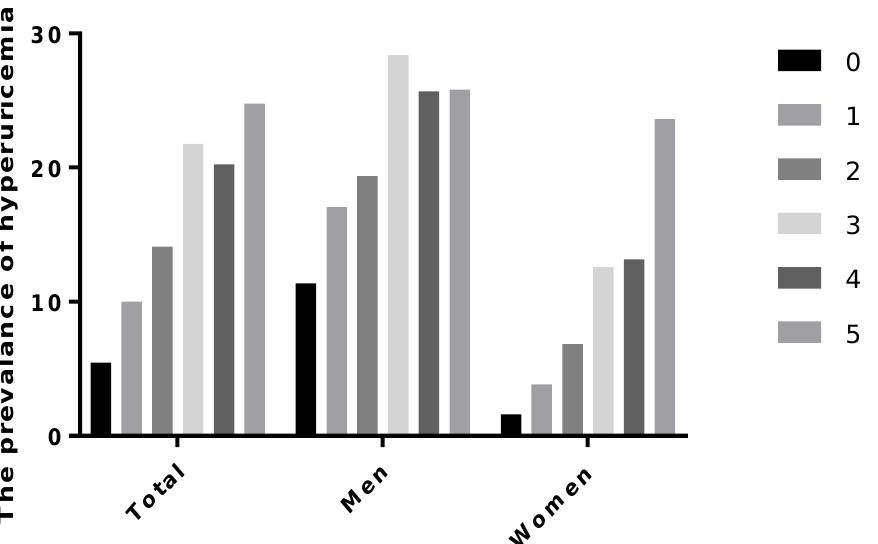
Figure 1. The prevalence of hyperuricemia according to the number of fulfillments of the components of metabolic syndrome.